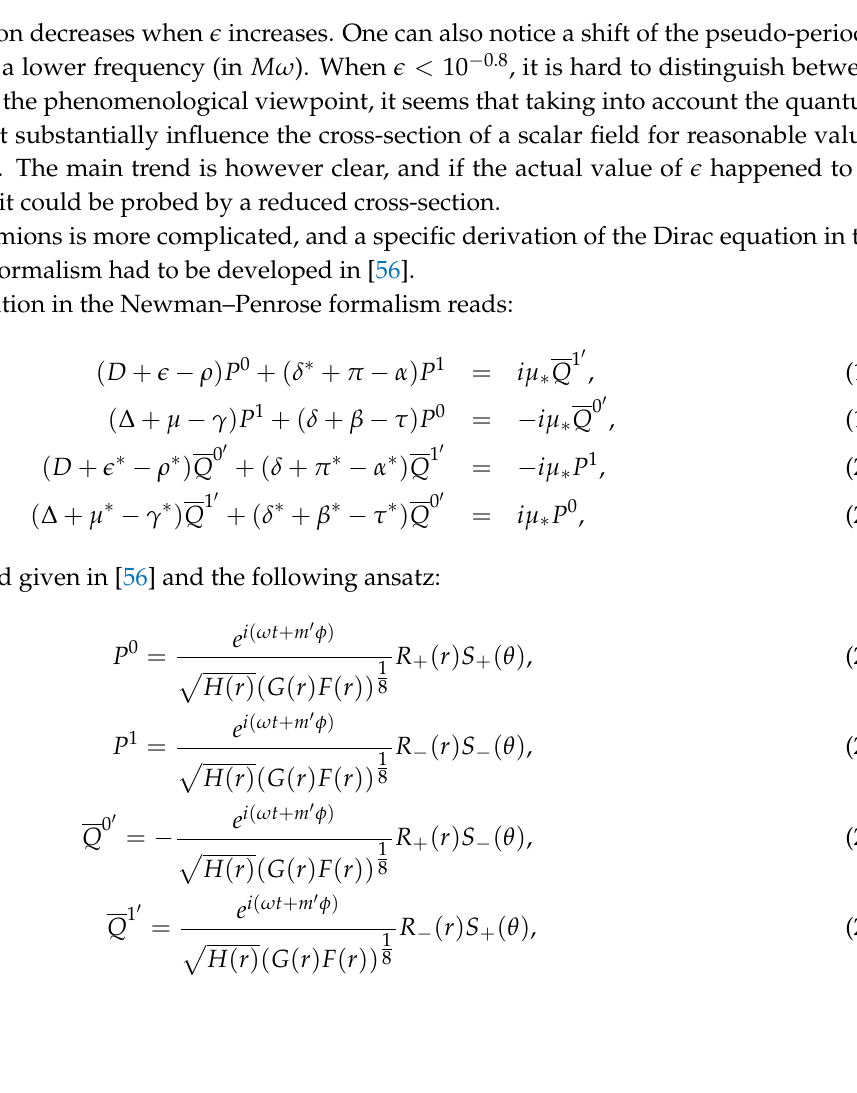
Figure 4. Emission cross-section for a scalar field with energy ω for a loop BH of mass M for different values of (cid:101) . From bottom to top: (cid:101) = 10 {− 0.3, − 0.6, − 0.8, − 1, − 3 } . The blue line, corresponding to (cid:101) = 10 − 3 , is superposed with the cross-section for a Schwarzschild BH. From